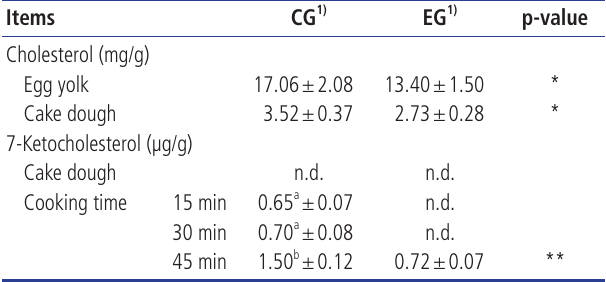
Table 6. Cholesterol and 7-ketocholesterol in egg yolks and cakes subjected to different cooking times (15, 30, and 45 minutes)